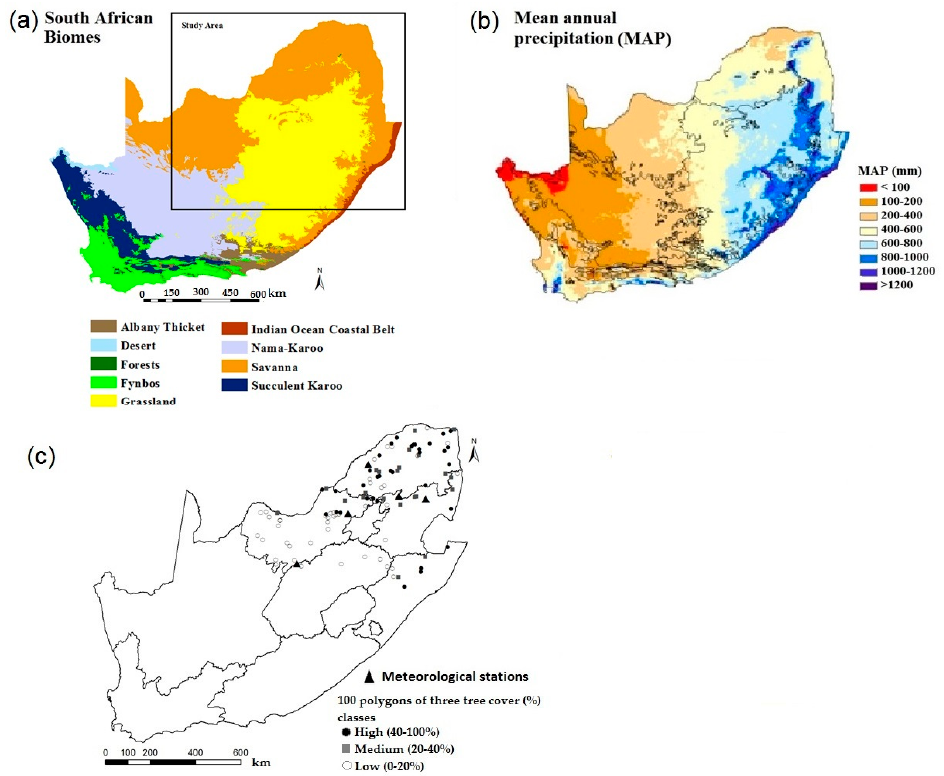
Figure 1. Biomes of South Africa ( a ) (Mucina and Rutherford, 2006); and mean annual precipitation ( b ) (Schulze, 2007). One hundred random plots selected to analyse spatial and temporal patterns in land surface phenological metrics ( c ).